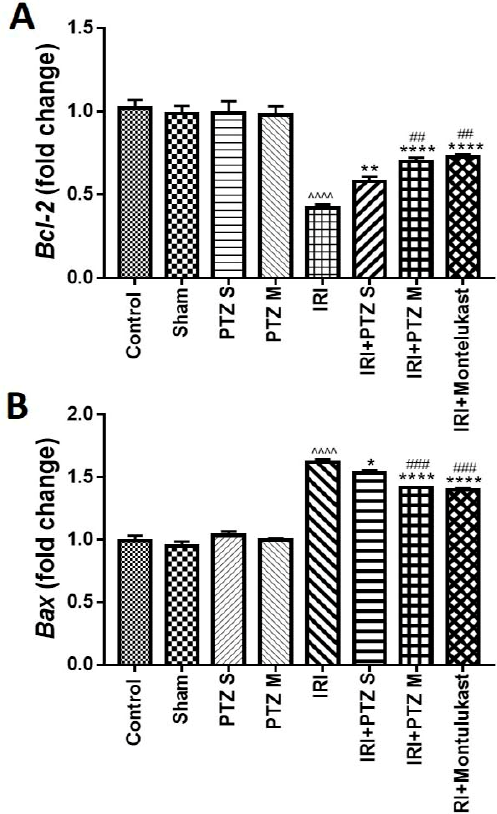
Figure 3. Expression of Bcl-2 ( A ) and Bax ( B ) genes in renal tissues. Quantitative RT-PCR was used to evaluate the gene expression in renal tissues for rats of different groups. Data represent fold change relative to the normal control group expression after normalization to GAPDH gene. Bars represent mean ± SEM. Significant difference between groups is analyzed by Student’s t -test after one-way ANOVA test (n = 8), where: ^^^^: p < 0.0001, compared to normal control group. *: p < 0.05, **: p < 0.01, ****: p < 0.0001, compared to IRI group. ##: p < 0.01, ###: p < 0.001, compared to (IRI + PTZ S) group.